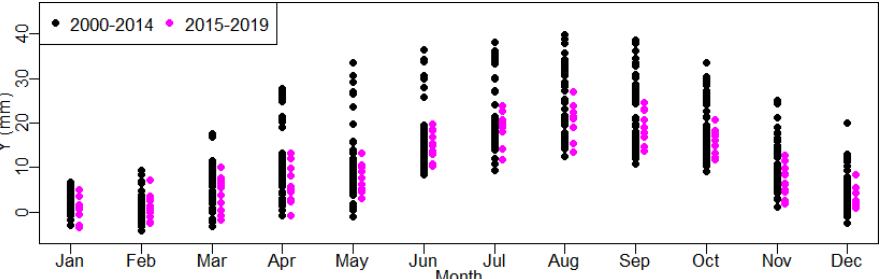
Figure 10. Radial displacements in FP3/5–277.07 m from 2000 to 2019 by month (training set: from 2000 to 2014 and predicted set: from 2015 to 2019).